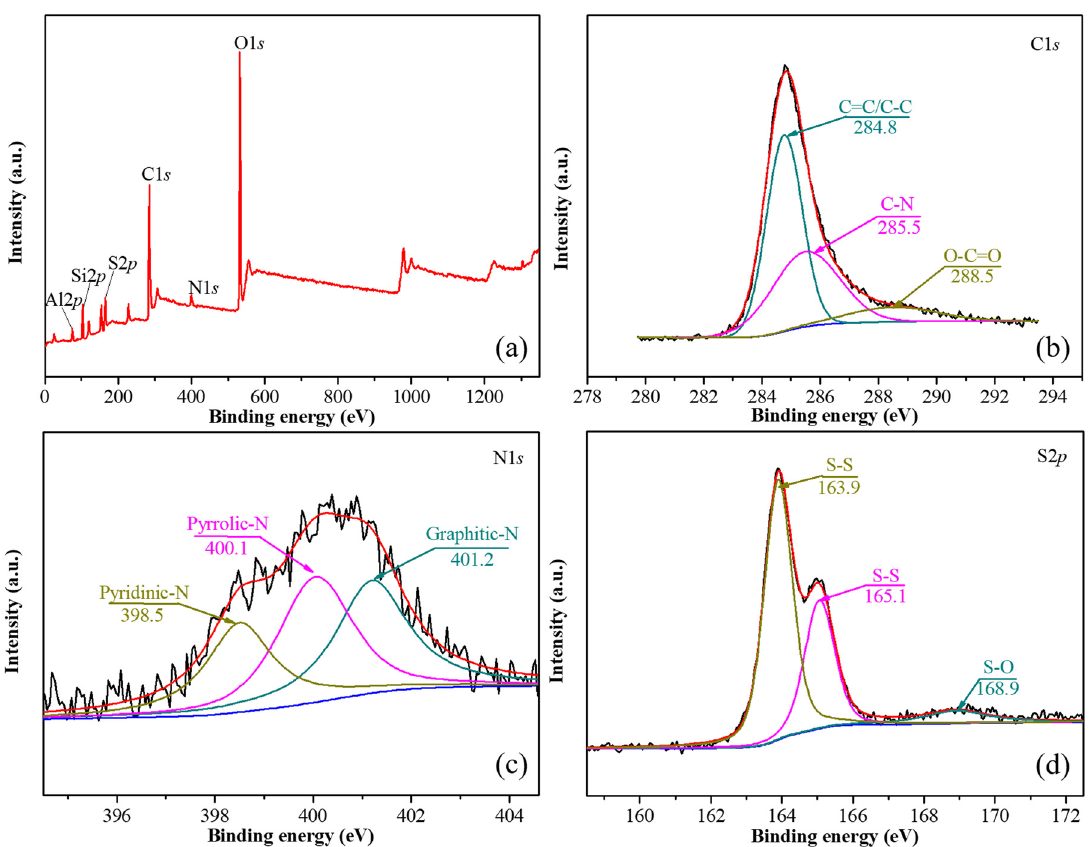
Figure 4: ( a ) XPS spectrum of S/Bent@C. ( b – d ) High - resolution XPS spectra of C1s, N1s, and